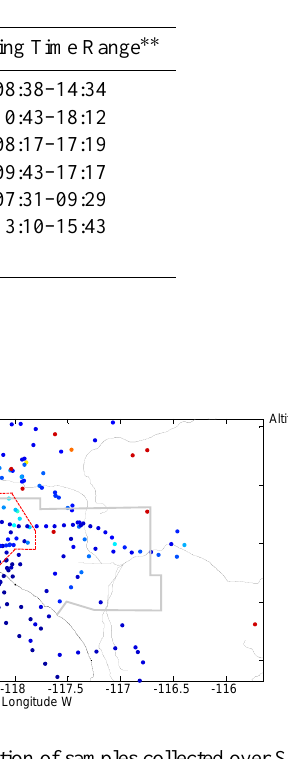
Table 1. Statistics of air samples collected over California and off the California coast during the four ARCTAS-CARB flights and two transit flights.